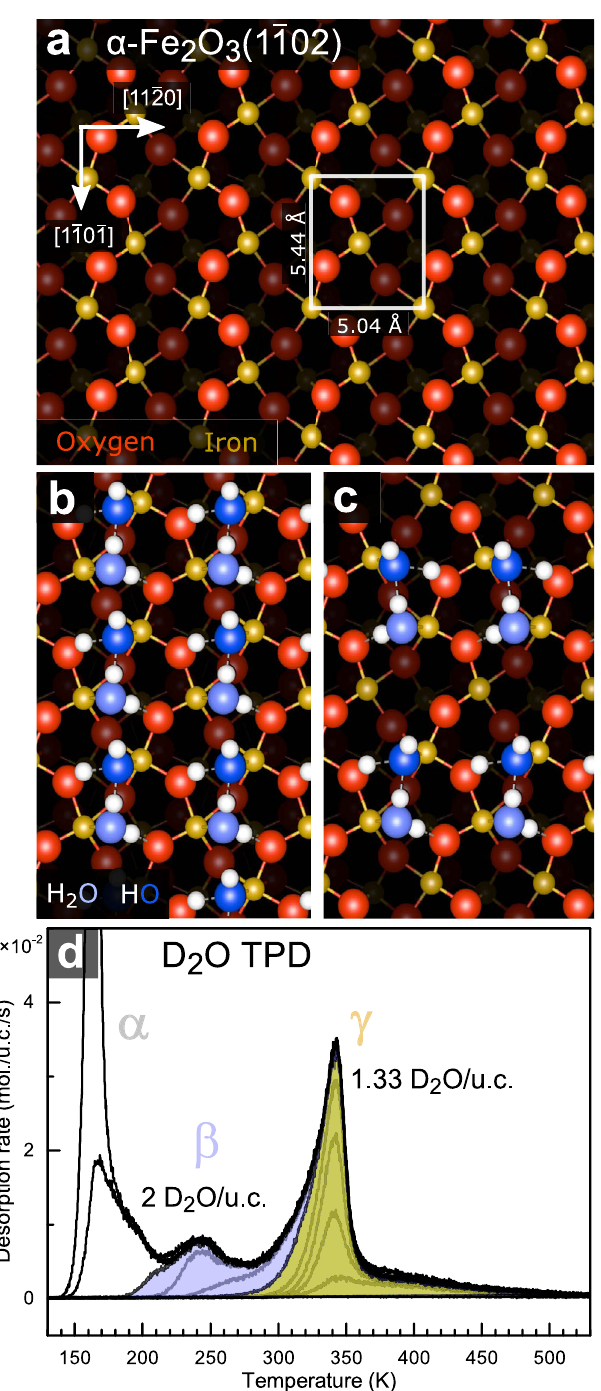
-- Fig. 1 Water adsorption on α -Fe 2 O 3 (1 102). a Top view on the bulk- truncated α -Fe 2 O 3 (1 (cid:1) 102) surface. The red (larger) and yellow (smaller) balls correspond to oxygen and iron; the surface unit cell contains two O and two Fe atoms. A full analysis of this surface termination is provided in ref. 24 . In this work, the azimuthal angle of 0° is de fi ned as the (1 (cid:1) 10 (cid:1) 1) direction. b , c Two phases of water adsorbed on this surface, both of which consist of partially-dissociated water dimers 25 . The bright blue and dark blue balls correspond to oxygen in H 2 O and OH, respectively. d D 2 O TPD (temperature ramp 1 K/s) shows two main desorption peaks ( β , γ ) before the multilayer forms ( α ). The saturation coverages of the β , γ peaks correspond to models shown in b and c ,